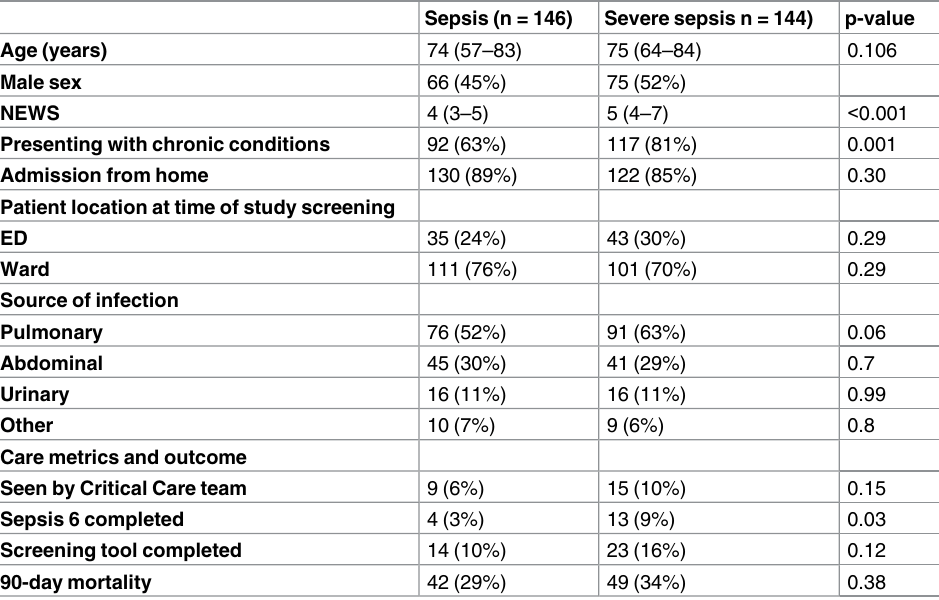
Table 4. Comparison of patients with sepsis and severesepsis